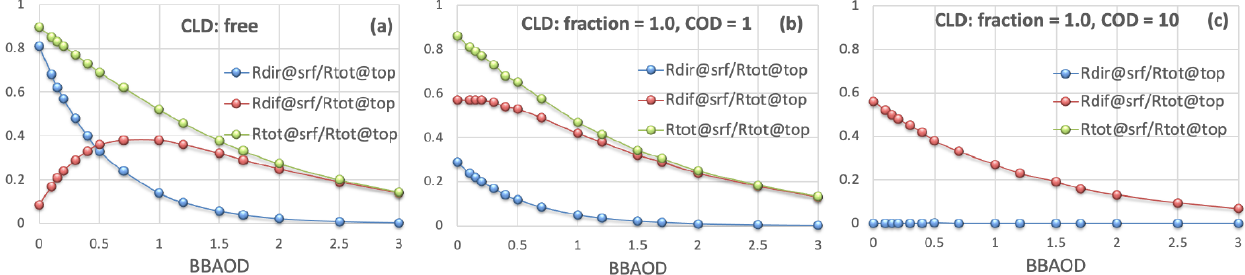
Figure 9. The ratio of Rdir@srf to Rtot@toa (blue), which presents the clearness index for the direct radiation portion (CIdir), the ratio of Rdiff@srf to Rtot@toa (red) for the diffuse radiation portion (CIdiff), and the ratio of Rtot@srf to Rtot@toa (green). Here, Rtot@toa is incoming total solar flux at the top of atmosphere (TOA), Rdir@srf is surface downward direct solar flux, Rdiff@srf is surface downward diffuse solar flux, and Rtot@srf is the sum of Rdir@srf and Rdif@srf. All Rs are over 400–700nm. (a) The change in the radiative flux ratios in BBAOD = 0–3 under clear-sky condition. (b) Same as (a) but under cloudy conditions (cloud fraction = 1) with COD = 1. (c) Same as (b) but for COD = 10. Calculations use the fast-JX radiation model column version adopting a standard atmospheric condition of the typical tropics at ozone column = 260 Dobson units, SZA (solar zenith angle) = 15 ◦ , and surface albedo = 0 . 1.